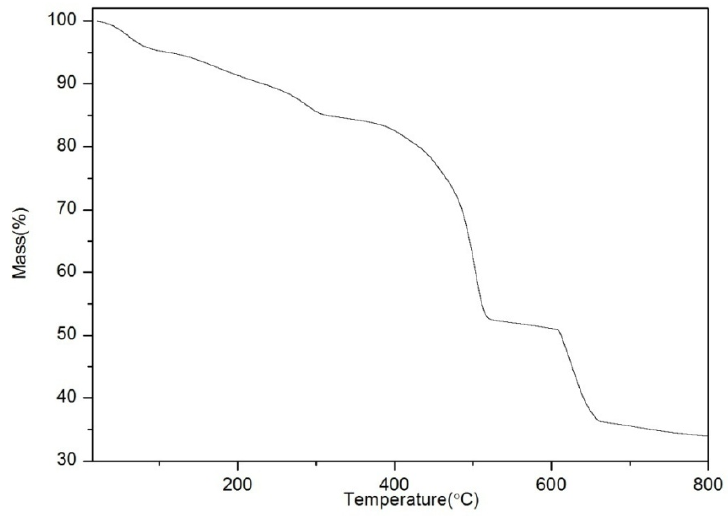
Figure 3. TG of Fe-MOFs.